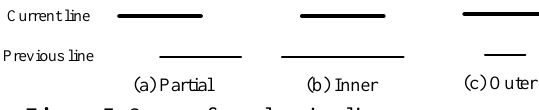
Figure 5 : Cases of overlapping lines